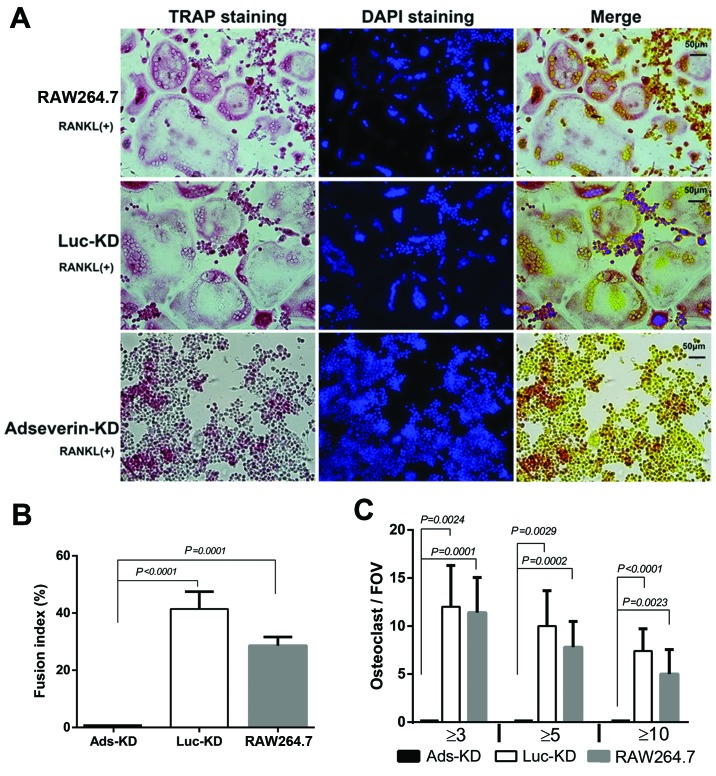
Adseverin (Ads)-knockdown RAW264.7 macrophages exhibit profound defects in osteoclastogenesis. Wild-type, luciferase and Ads-knockdown RAW264.7 macrophages (5×104 cells) were seeded into 8-well chamber slides and stimulated for 4 days with 60 ng/ml sRANKL to induce osteoclastogenesis. Images of TRAcP-stained osteoclasts were obtained (magnification, ×200). To visualize the nuclei, the cells were stained with 4′,6-diamidino-2-phenylindole (DAPI). (A) In order to confirm the role of Ads in osteoclastogenesis (OCG), OCG from Ads-knockdown and Luc-knockdown cells was compared. OCG was almost completely blocked in Ads-knockdown cells. (C) Osteoclasts were defined as TRAcP+ multinucleated cells containing ≥3 nuclei. TRAcP+ osteoclasts were classified based on the number of nuclei (≥3, ≥5 or ≥10 nuclei) within these osteoclasts and counted in 10 random fields of view (FOVs). (B) The fusion index [FI = (number of nuclei from total osteoclasts/nuclei of total cells) ×100%] of Ads-knockdown cells markedly decreased (FI =0) compared to the control Luc-knockdown cells (FI =41.40%) and untransfected control RAW264.7 cells (FI =26.11%). RANKL, receptor activator of nuclear factor-κB ligand.